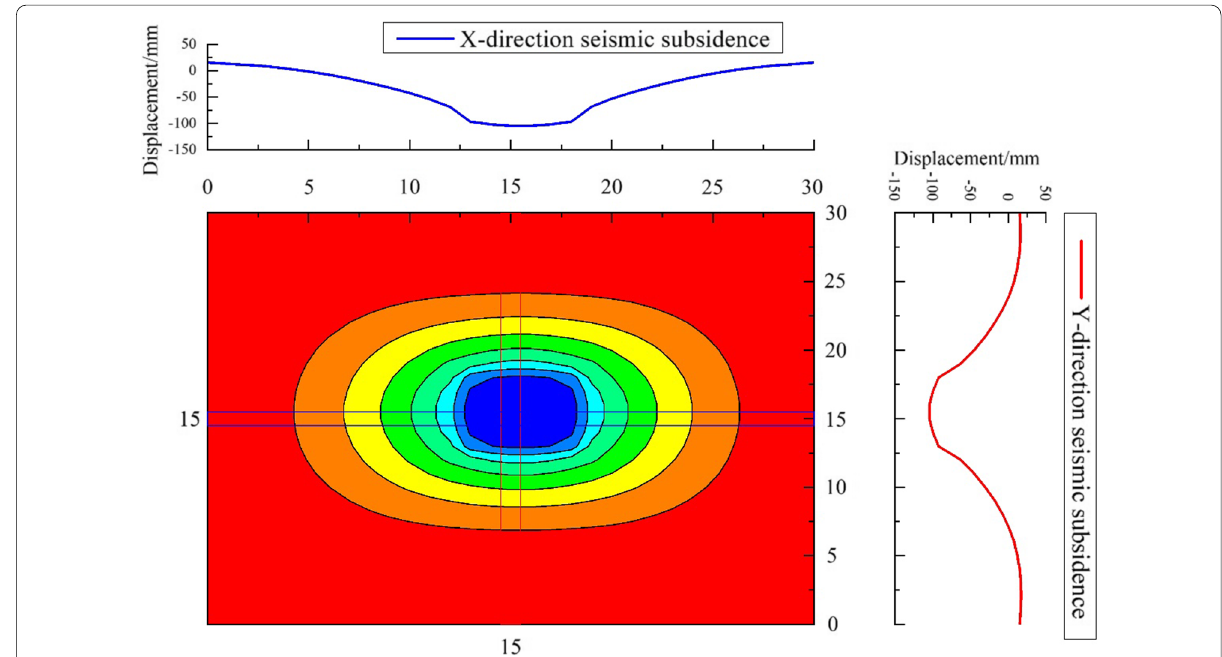
Fig. 7 Seismic subsidence of ground surface due to 0.15 g El Centro ground motion (cross-sectional view)